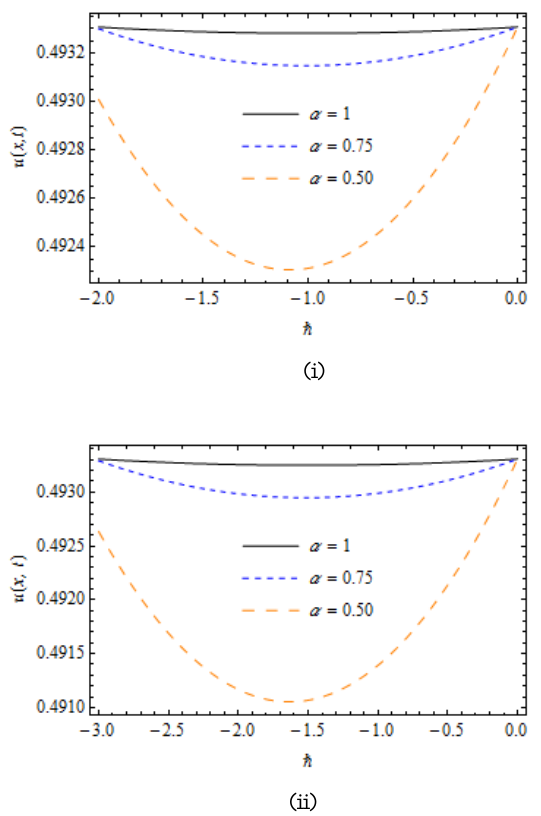
Figure. 9. ℏ -curve for acquired solution 𝑢(𝑥, 𝑡) for Ex. 3 when (i) 𝑛 = 1 and (ii) 𝑛 = 2 when 𝑥 = 5, 𝑎 = 4, and 𝑡 = 0.001 for distinct 𝛼 . Table 4. Numerical simulations for Ex. 3 at 𝑛 = 1, 𝛼 = 1,ℏ = −1, B 0 = 1,𝑎 = 1, 𝜆 = 2 for various values of 𝑥 and at 𝑡 = 0.001,𝑡 = 0.002